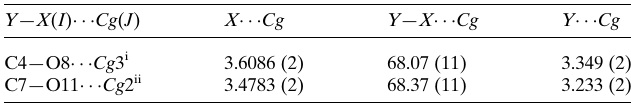
Table 3 Analysis of Y — X (cid:2)(cid:2)(cid:2) Cg ( (cid:4) -ring) interactions (A˚ , (cid:3) ).